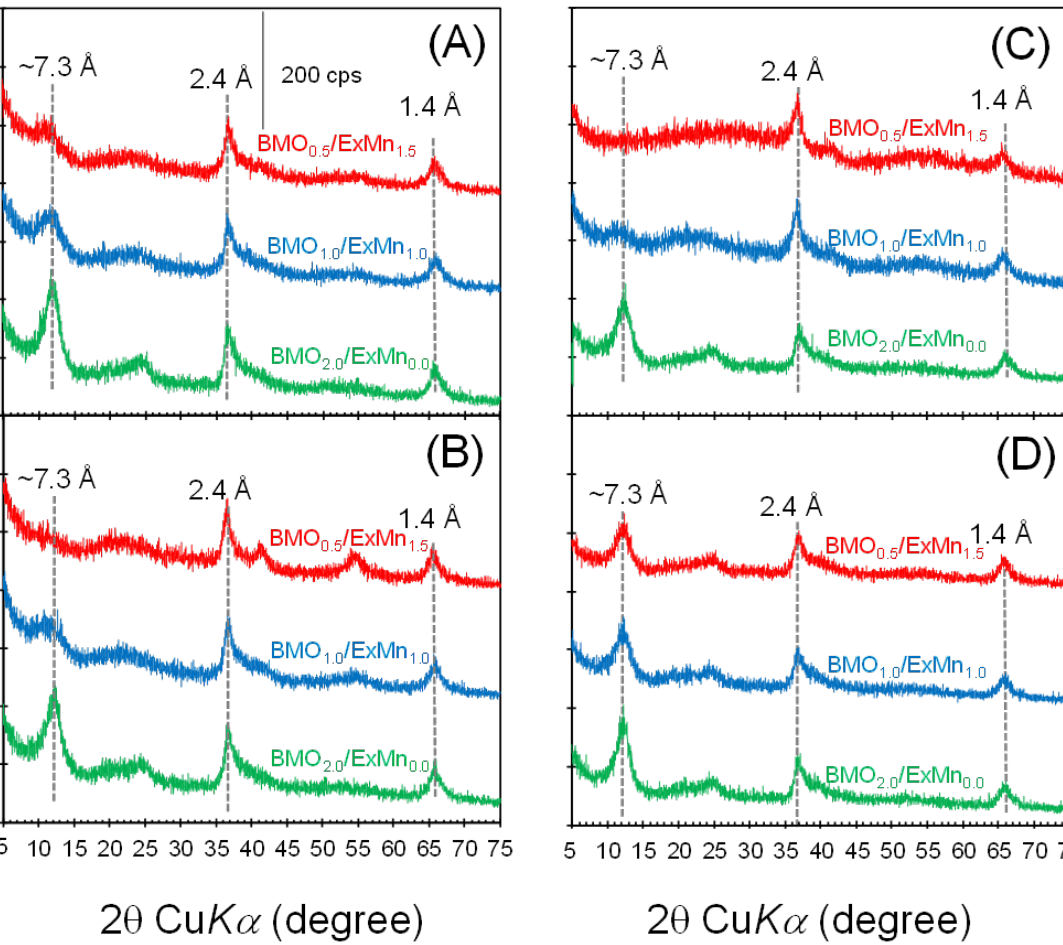
Figure 6. X-ray diffractions of the resultant BMOs after sequestration experiments for ( A ) V(V), ( B ) Mo(VI), and ( C ) W(VI) (~1 mM) under the experimental conditions of BMO 2.0 /ExMn 0.0 , BMO 1.0 /ExMn 1.0 , and BMO 0.5 /ExMn 1.5 , respectively (See Table 1). ( D ) Na 2 SO 4 was used as the experimental control, where no apparent changes in the XRD patterns were observed. The error bars represent the standard deviation ( n = 3). (See Table 1). The amounts of oxyanions sequestered (V seq. , Mo seq. , and W seq. ) were normalized relative to reducible Mn. The error bars represent the standard deviation ( n =